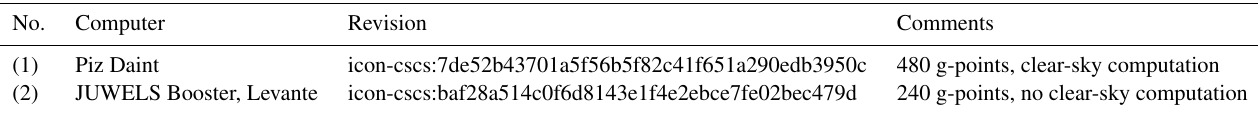
Table 2. Model revisions and their usage.